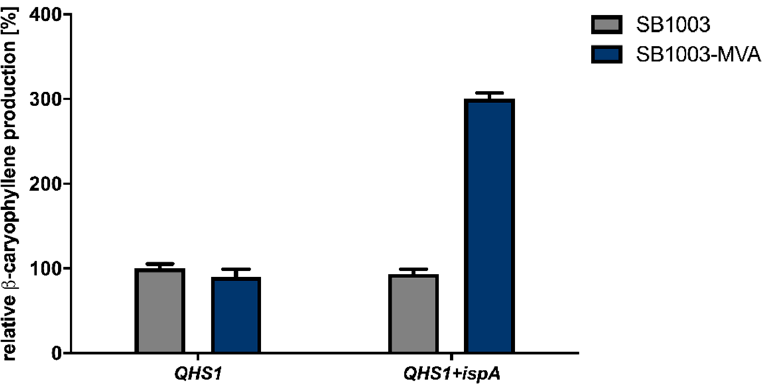
Figure 1. Heterologous β -caryophyllene production in the R. capsulatus strains SB1003 and SB1003- MVA. The β -caryophyllene synthase gene QHS1 from A. annua was expressed in R. capsulatus SB1003 wild type (grey bars) and SB1003-MVA (blue bars), which additionally carries the MVA gene cluster from P. zeaxanthinifaciens to enable a second isoprenoid biosynthesis route. Moreover, the ispA gene encoding the R. capsulatus FPP synthase was co-expressed on the same plasmid to further enhance sesquiterpene production titers. Product formation was determined in cell cultures after three days of photoheterotrophic cultivation (gas-tight hungate tubes, 30 ◦ C) under ammonium depletion and constant illumination with bulb light (3.6 mW cm − 2 at 850 nm). The produced β -caryophyllene was sampled in overlaid n -dodecane phases for GC-FID analysis. The increase of β -caryophyllene production in engineered R. capsulatus strains is shown as relative values. To this end, the R. capsulatus SB1003 carrying the plasmid-encoded QHS1 gene was used as a reference strain. Values are means of three independent biological replicates ( n = 3) and error bars indicate the respective standard